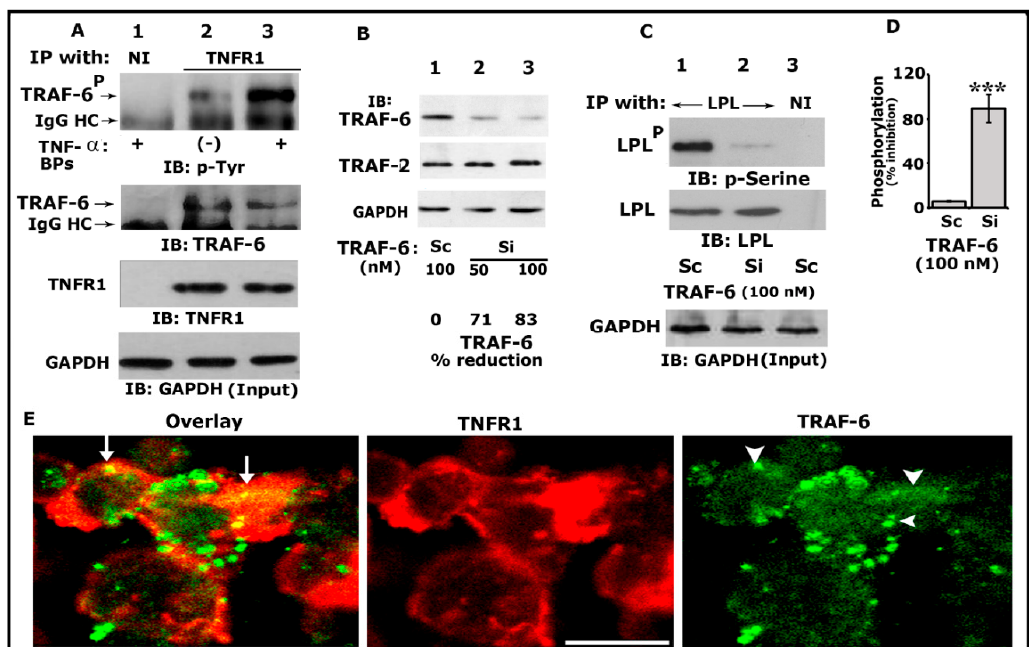
Figure 1. Analysis of the phosphorylation of TRAF-6 by immunoblotting and interaction of TRAF-6 with TNFR1. An equal amount of lysate proteins was used for the immunoblotting (IB) analyses shown in panels ( A – C ). IB analyses were performed sequentially with the indicated antibody after stripping the blot shown in each panel ( A – C ). An equal amount of total protein used for immunoprecipitation was assessed by direct IB of the lysates (Input) with a GAPDH antibody ( A , C , bottom panels). ( A ) IB analysis of the interaction of TRAF-6 with TNFR1. Osteoclasts untreated (indicated by a minus sign) or treated (indicated by plus signs) with TNF- α and bone particles for 3–4 h were immunoprecipitated with an antibody to TNFR1 (lanes 2 and 3) or nonimmune serum (NI; lane 1). IB analyses were performed sequentially with indicated antibodies. Phosphorylated TRAF-6 is indicated as TRAF-6 P ( B ). The effects of siRNA of TRAF-6 on the cellular levels of TRAF-6 and TRAF2. An equal amount of total lysate made from osteoclasts treated with a siRNA (Si) or scrambled or RNAi (Sc) was used for the indicated IB analyses in ( B ). GAPDH was used as a loading control (bottom). The percent reduction of TRAF-6 protein for the representative blot is provided below the panel. The experiment was repeated thrice and obtained a comparable reduction. ( C ) The effects of siRNA of TRAF-6 on the phosphorylation of LPL. An equal amount of lysate proteins was immunoprecipitated with an antibody to LPL (lanes 1 and 2) or nonimmune serum (lane 3). IB analyses were performed with the indicated antibodies in the figure. Phosphorylated LPL is indicated as LPL P ( D ). Percent inhibition of LPL phosphorylation is provided in the graph. *** p < 0.001 versus control RNAi ( C ) treated osteoclasts. Values were expressed as mean ± SEM ( n = 3). Uncropped images of autoradiograms ( A – C ) are provided in the Supplementary Materials. ( E ) Confocal analysis of the localization of TRAF-6 and TNFR1 in osteoclasts plated on dentine slices in the presence of TNF- α for 2–3 h. The yellow color (indicated by arrows) in the overlay panel represents the colocalization of TRAF-6 with TNFR1. Arrowheads in the green panel point to TRAF-6 localization, where colocalization is shown in the overlay panel. Scale bar: 100 µm.